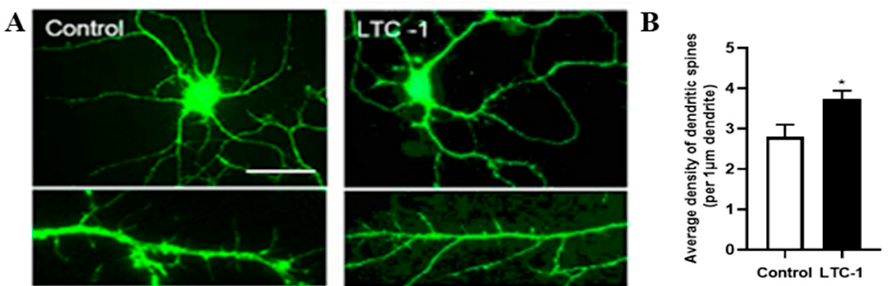
Figure 9. The dendritic spine density of hippocampal neurons increased after treatment with LTC-1. ( A ) The growth status of hippocampal neuron dendritic spines after 24 h of treatment. Scale = 10 µ m. ( B ) Statistical graph of dendritic spine density. The mean and standard deviation are used to express the data. One-way ANOVA was used in the statistical analysis, followed by Tukey’s multiple comparison test, * p < 0.05 vs. control group.